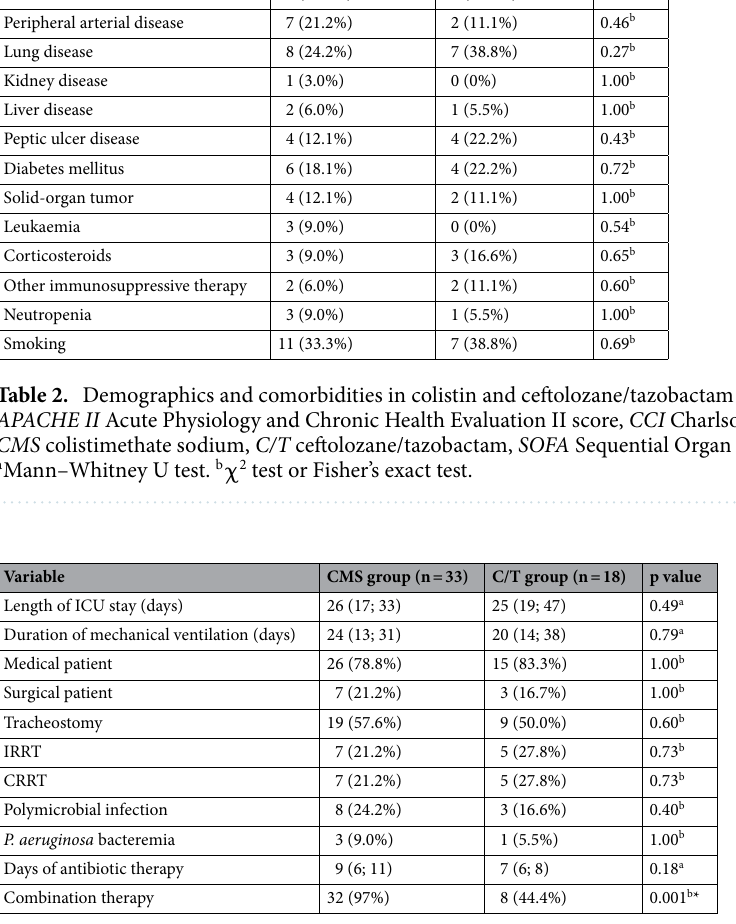
Table 3. Treatment characteristics in colistin and ceftolozane/tazobactam treated patient groups. Data are expressed as median (interquartile range) and absolute numbers (percentage). CRRT continuous renal replacement therapy, CMS colistimethate sodium, C/T ceftolozane/tazobactam, ICU intensive care unit, IRRT intermittent renal replacement therapy, P. aeruginosa Pseudomonas aeruginosa . a Mann–Whitney U test. b χ 2 test or Fisher’s exact test. *p <